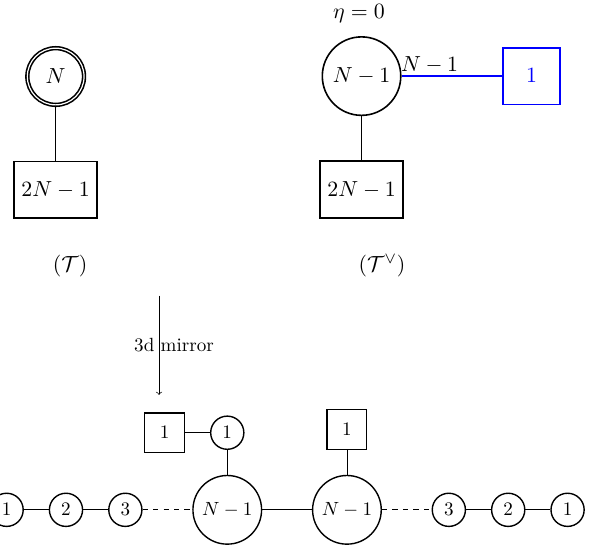
Figure 17 . The simplest example of an IR duality discussed above. The partition functions of the two theories T and T ∨ agree only when η = 0 . The 3d mirror for the two theories T and T ∨ is also